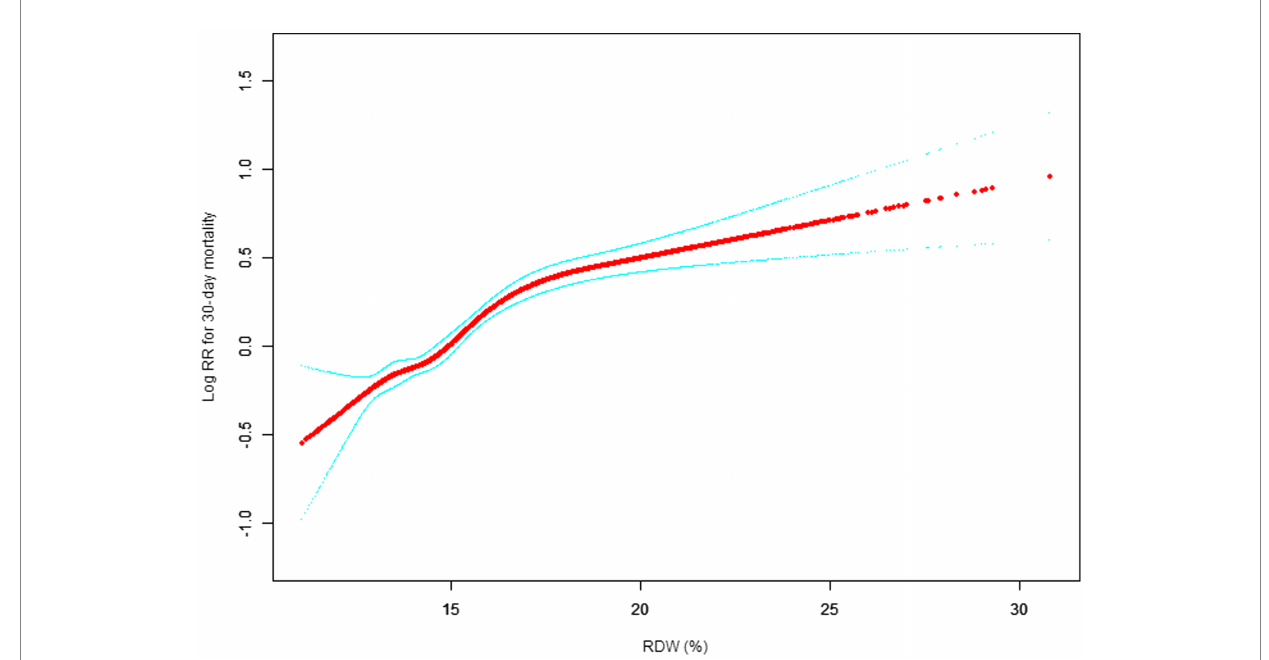
FIGURE 2 Association between RDW and 30-day all-cause mortality. (After adjustment for other covariates). A generalized additive model (GAM) revealed a threshold, nonlinear relationship between RDW and 30-day mortality. The smooth curve fit between variables is shown by a solid red line. The 95% confidence interval from the fit is represented by imaginary blue line.